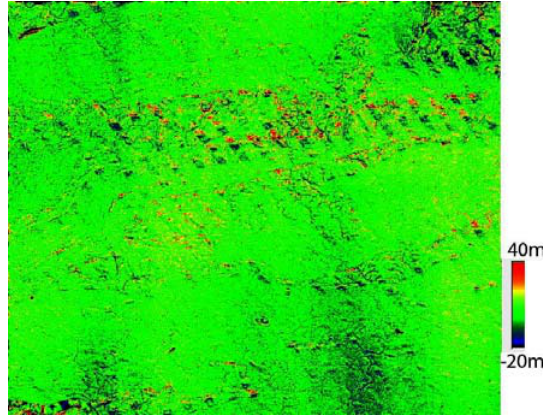
Figure 4: height difference ACE2 GDEM against reference DTM, Pennsylvania